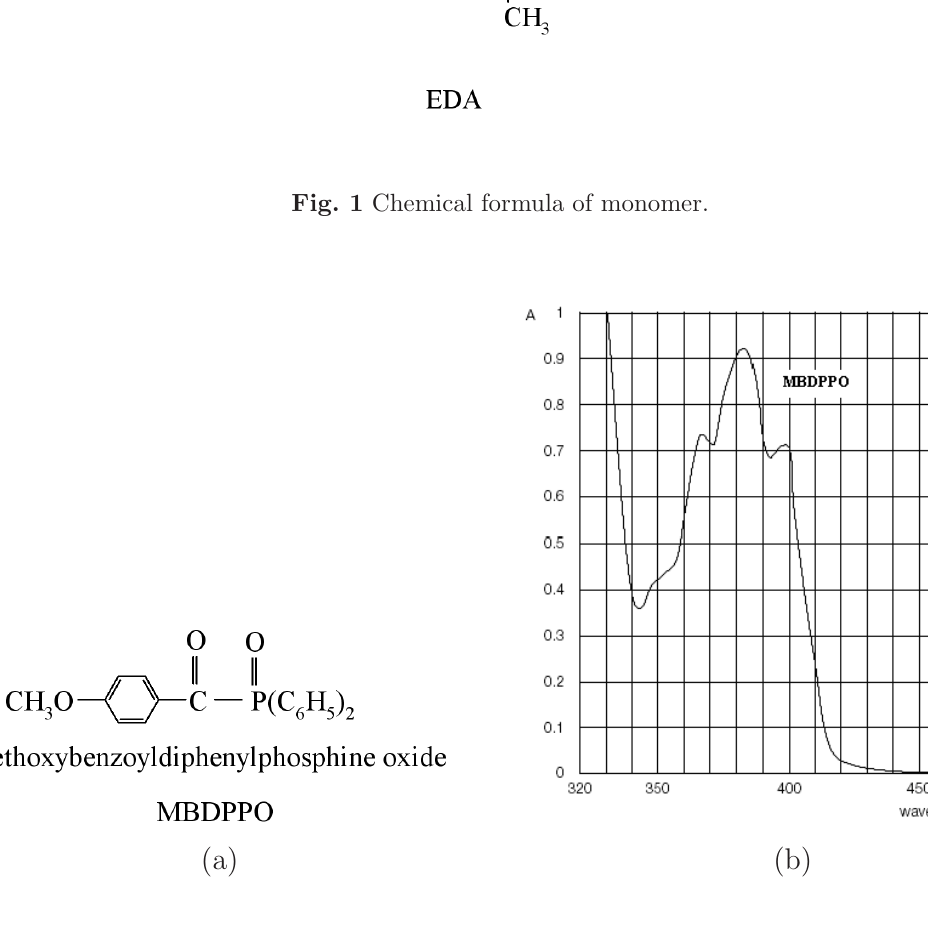
Fig. 2 Chemical formula of photoinitiator (a) and UV absorption spectrum for MBDPPO in toluene (c=0.0015 mol l − 1